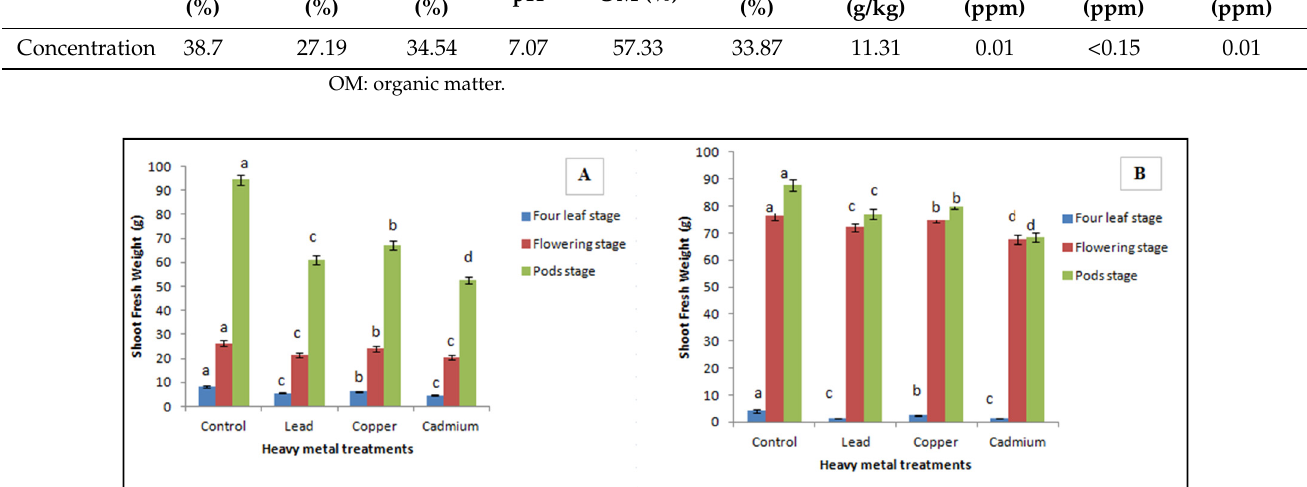
Figure 1. Response of bean plants ( A ) (a, b, c, d) and faba bean plants ( B ) (a, b, c, d) to HM treatments at different stages of growth, depicted for the fresh weight of the shoots (leaves and stems).